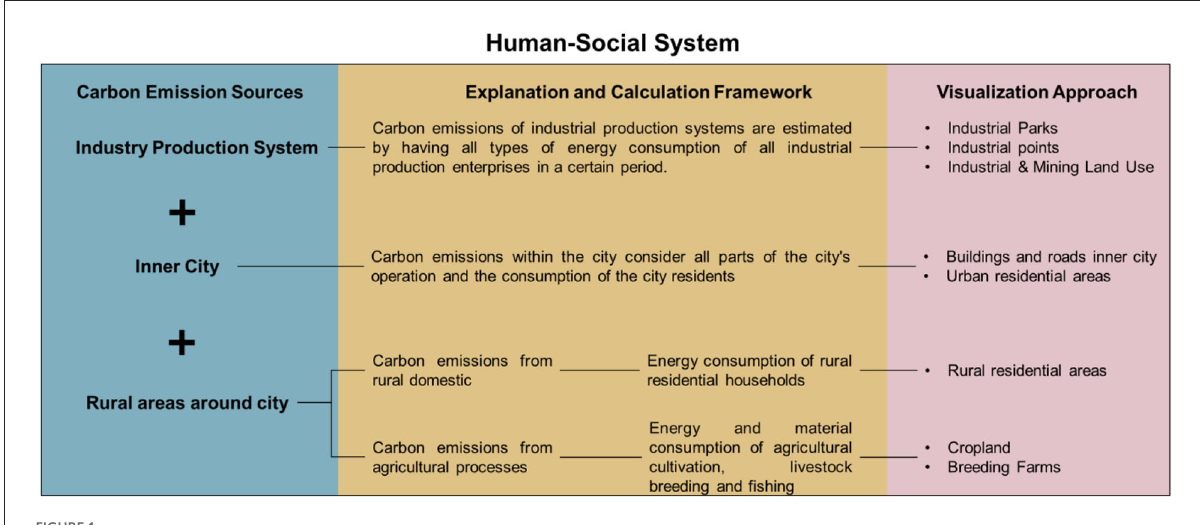
FIGURE1 The framework for regional carbon emission calculation and visualization of human-social system.